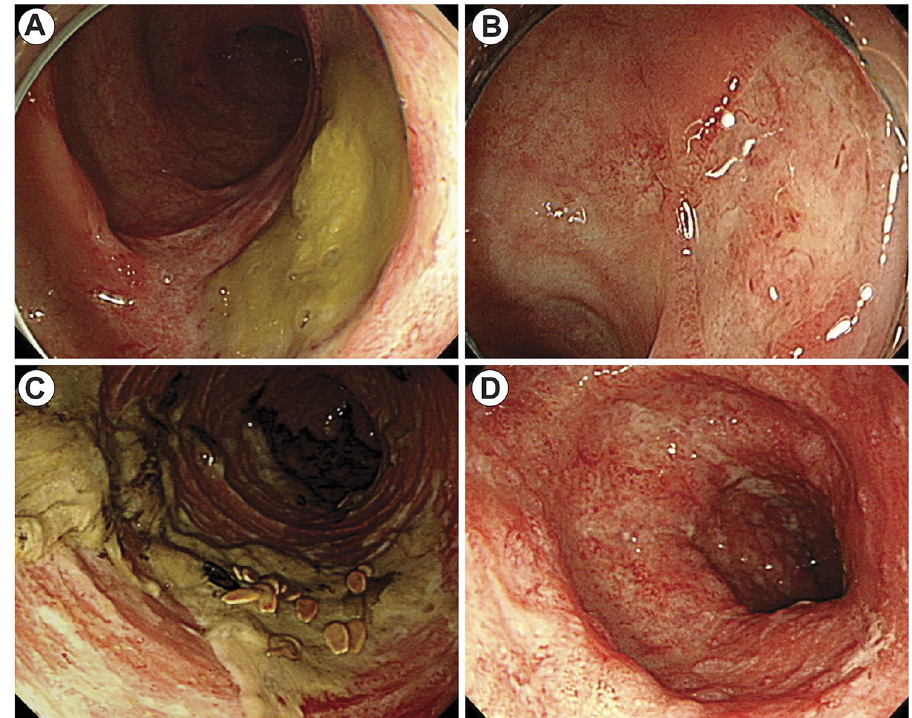
Figure 2. Endoscopic types according to gross features. ( A ) Discrete ulcerative type with exudate. ( B ) Discrete ulcerative type without exudate. ( C ) Diffuse erythematous type with exudate. ( D ) Diffuse erythematous type without exudate. All images ( A – D ) are cytomegalovirus colitis.